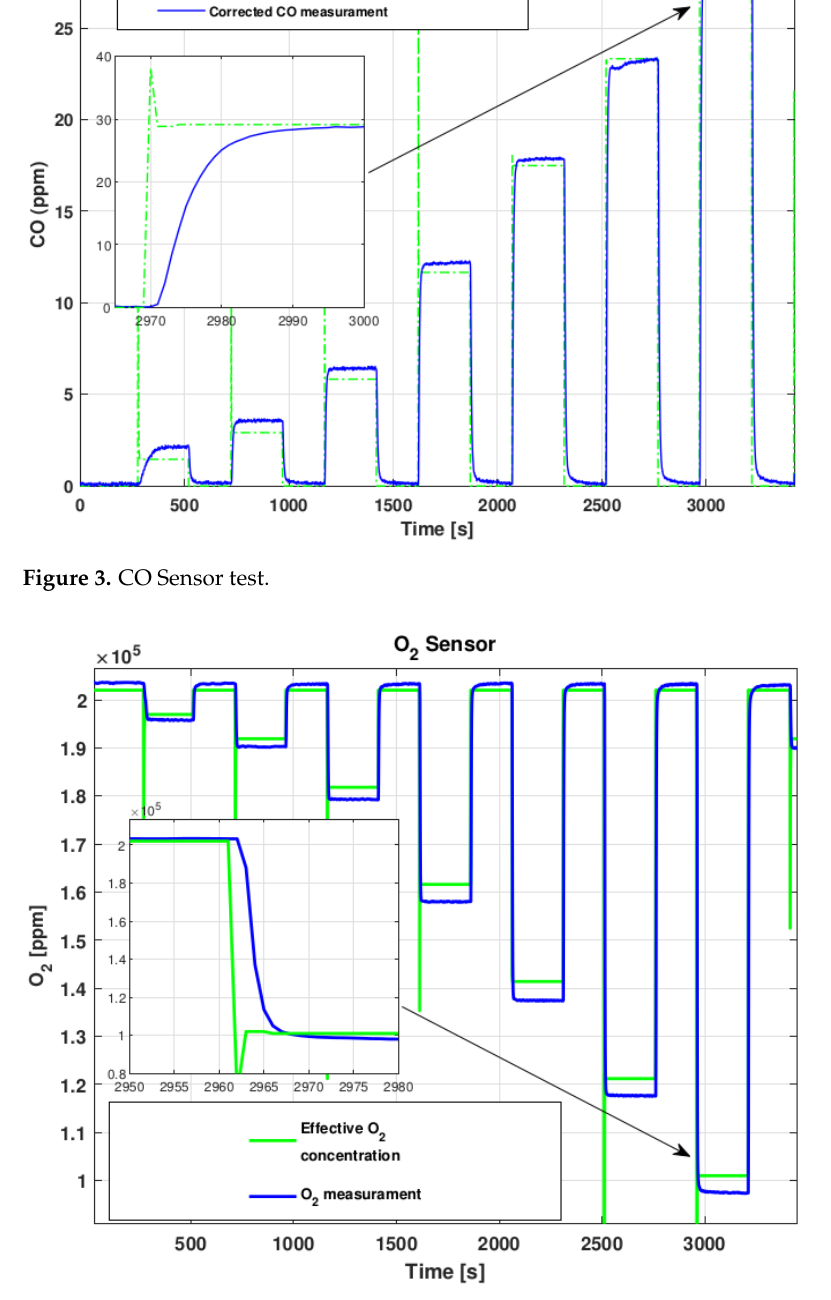
Figure 4. O 2 Sensor